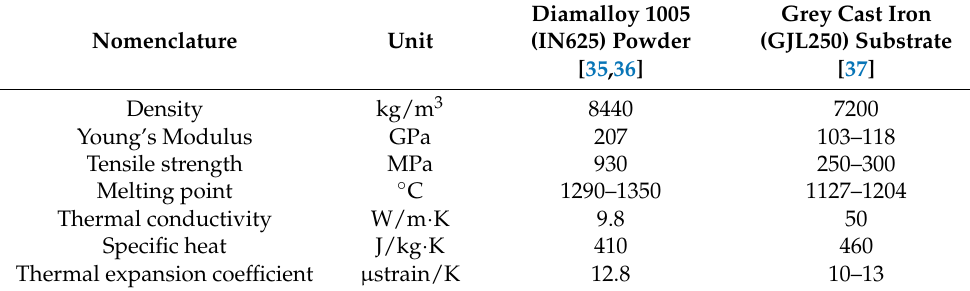
Table 1. Material properties of the powder and substrate.